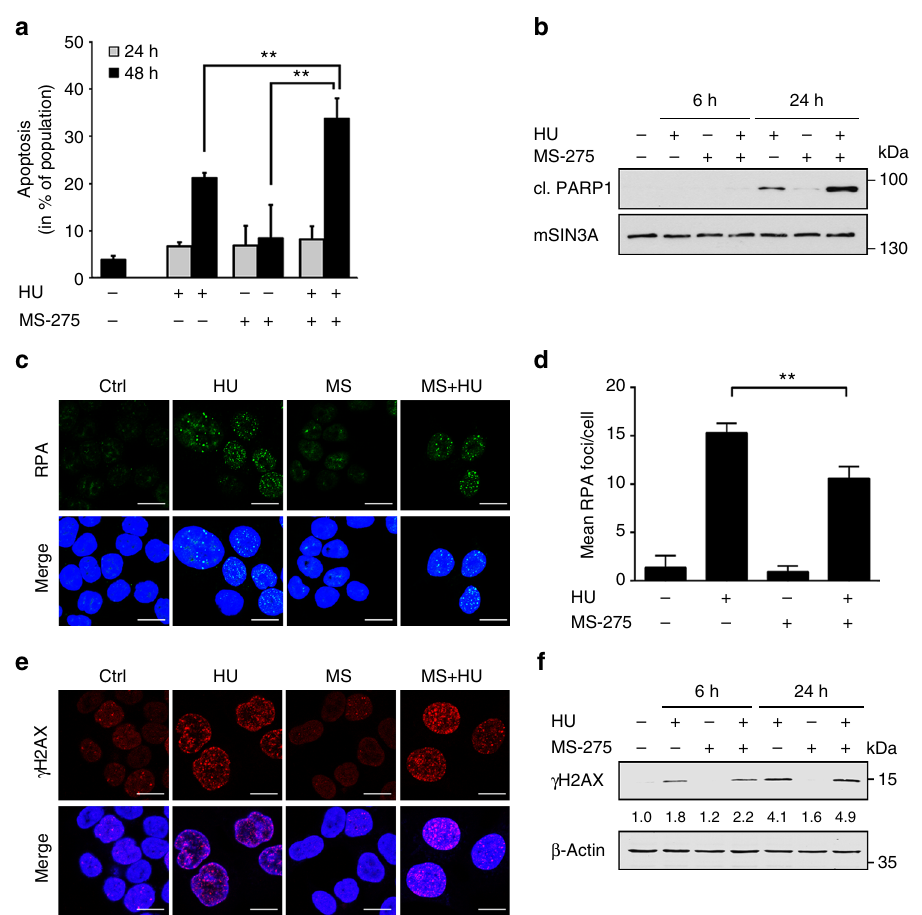
Fig. 3 DNA damage and apoptosis in the presence of hydroxyurea and MS-275. a Flow cytometry analysis of HCT116 cells using Annexin-V-FITC staining. Cells were treated with 1 mM hydroxyurea (HU), 2 µ M MS-275 or both for 24 – 48 h. Results represent the mean ± SD ( n = 3; one-way ANOVA, ** P < 0.01). b HCT116 cells were treated with 1 mM HU and 2 µ M MS-275 for 6 and 24 h. PARP1 cleavage (cl. PARP1) was analysed by western blot. mSIN3A served as loading control ( n = 3). c HCT116 cells were treated with 1 mM HU and 2 µ M MS-275 for 24 h, fi xed and incubated with RPA-speci fi c antibody (green). Staining with secondary antibody was performed using Alexa Fluor-488-coupled antibody and TO-PRO3 was used to visualise nuclei. Representative images are shown ( n = 3; scale bar, 10 µ m). d Analysis of RPA foci per cell in HCT116 cells. Number of foci was determined using ImageJ software. Data represent the mean ± SD ( n = 3; one-way ANOVA; ** P < 0.01). e HCT116 cells were cultured with HU (1 mM) and/or MS-275 (2 µ M) for 24 h. In the following, samples were fi xed, incubated with ɣ H2AX antibody (phospho-S139-H2AX) and stained with Alexa Fluor-488-coupled secondary antibody (red). TO-PRO3 was used for nuclear staining. Representative images are shown ( n = 3; scale bar, 10 µ m). f Cells were treated with 1 mM HU and 2 µ M MS-275 for 6 and 24 h. Whole-cell lysates were analysed for ɣ H2AX by western blot. β -Actin was used as loading control. Numbers indicate densitometric analysis of ɣ H2AX signals relative to untreated control and normalised to loading control ( n =